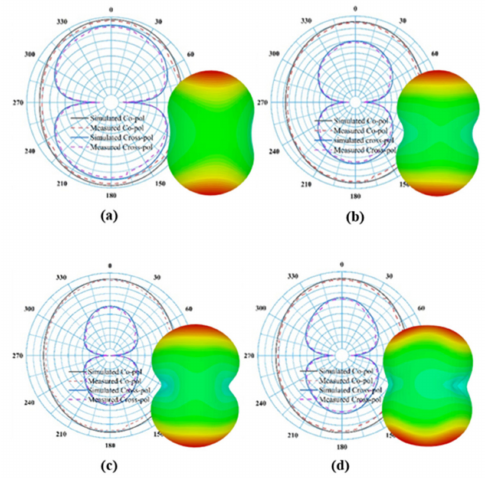
Figure 10. A 2D (measured and simulated) and a 3D (measured) radiation patterns for the dual arm-LP antenna for different frequencies such as ( a ) 0.78 GHz, ( b ) 1.8 GHz, ( c ) 2.38 GHz and ( d ) 2.9